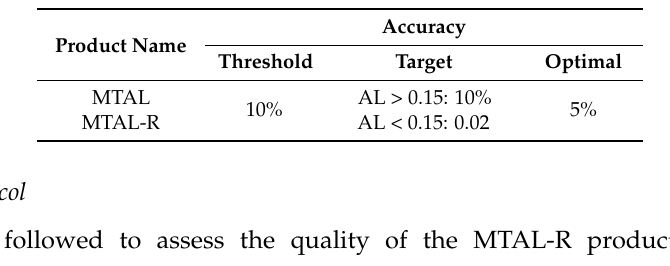
Table 2. LSA SAF MSG-based product requirements for MTAL